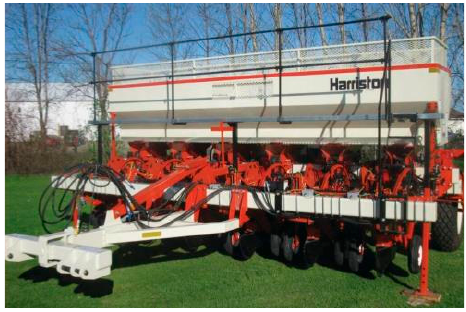
Figure 18. Harriston Clamp planter. Reprinted with permission from ref. [83] Copyright 2019 Harriston Industries.